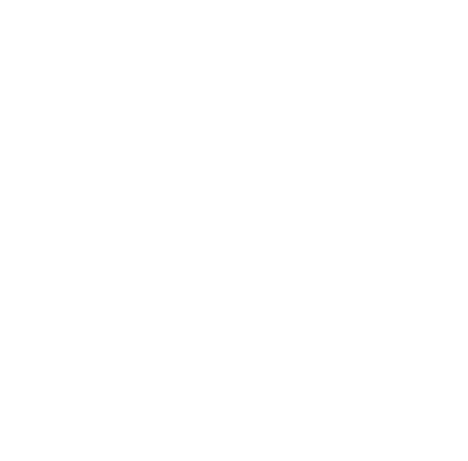
Table 4. Mesh points analysis of the fluid model.